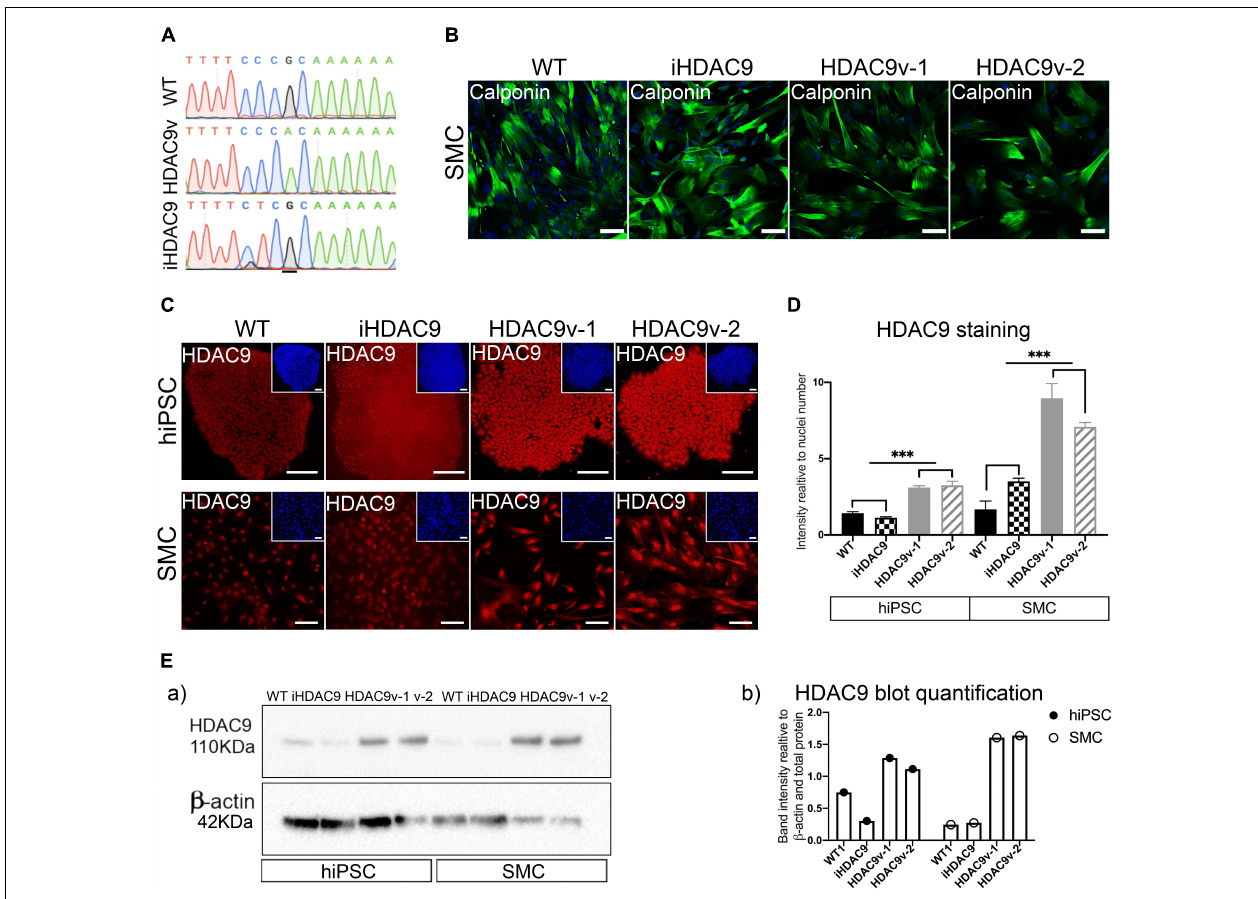
FIGURE 1 | The rs2107596 stroke risk variant correlates with increased HDAC9 expression in two hiPSC derived smooth muscle cells (SMC) lines. (A) Representative genomic sequencing of hiPSC for WT, HDAC9 risk variant (HADC9v), and isogenic corrected (iHDAC9) lines. (B) hiPSC-derived SMC stained for specific SM marker (Calponin) at mature stage (2 weeks in serum) for WT1, iHDAC9, HDAC9v-1 and HDAC9v-2 lines (C) Immunostaining for HDAC9 in hiPSC and SMC for WT, iHDAC9, HDAC9v-1, and HDAC9v-2 lines. Nuclear counterstaining performed with DAPI (insets). (D) Quantification of HDAC9 staining relative to cell numbers in hiPSC and SMC stages for WT ( n = 3), iHDAC9, HDAC9v-1, and HDAC9v-2 lines. (E) Cropped blot of HDAC9 protein in WT1, iHDAC9, HDAC9v-1 and HDAC9v-2 SMC (a) and quantification (b). hiPSC = induced pluripotent stem cells; SMC = smooth muscle cells; iHDAC9 = isogenic control; HDAC9v-1 = stroke risk variant line 1; HDAC9v-2 = stroke risk variant line 2. Scale bar = 100 µ m. The results are presented as means ± SD of three independent experiments. ∗∗∗ P < 0.001. Statistical analysis was performed by 1-way ANOVA with Tukey’s multiple comparison